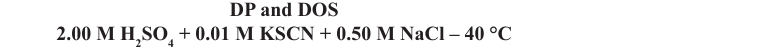
/Q values obtained for SD-A and SD-B in 2.00 M H r a